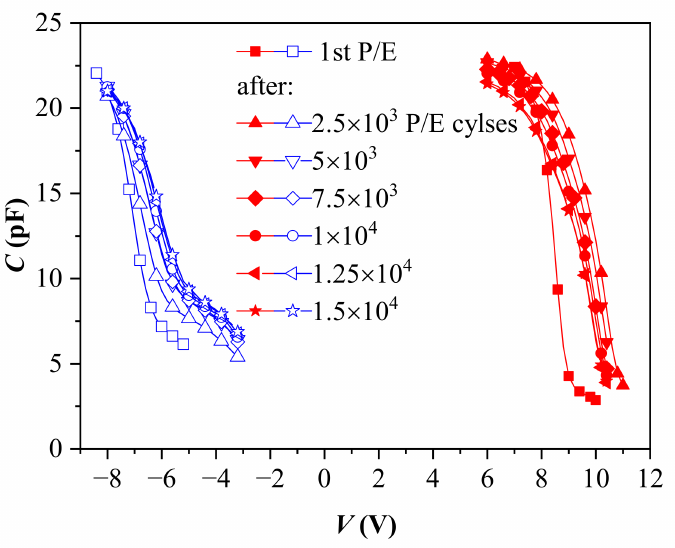
Figure 7. C-V curves during the endurance measurements with ± 25 V voltage